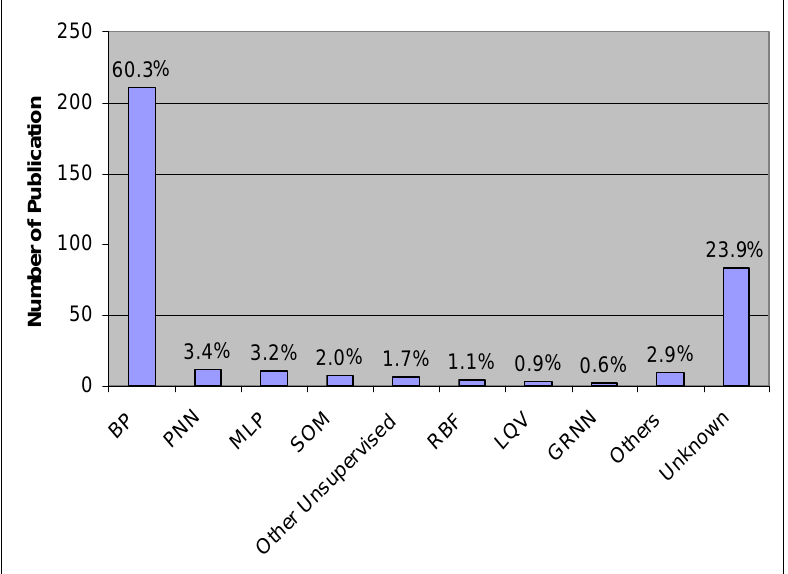
Figure 12. ANN method distribution of applications in agricultural and biological engineering.